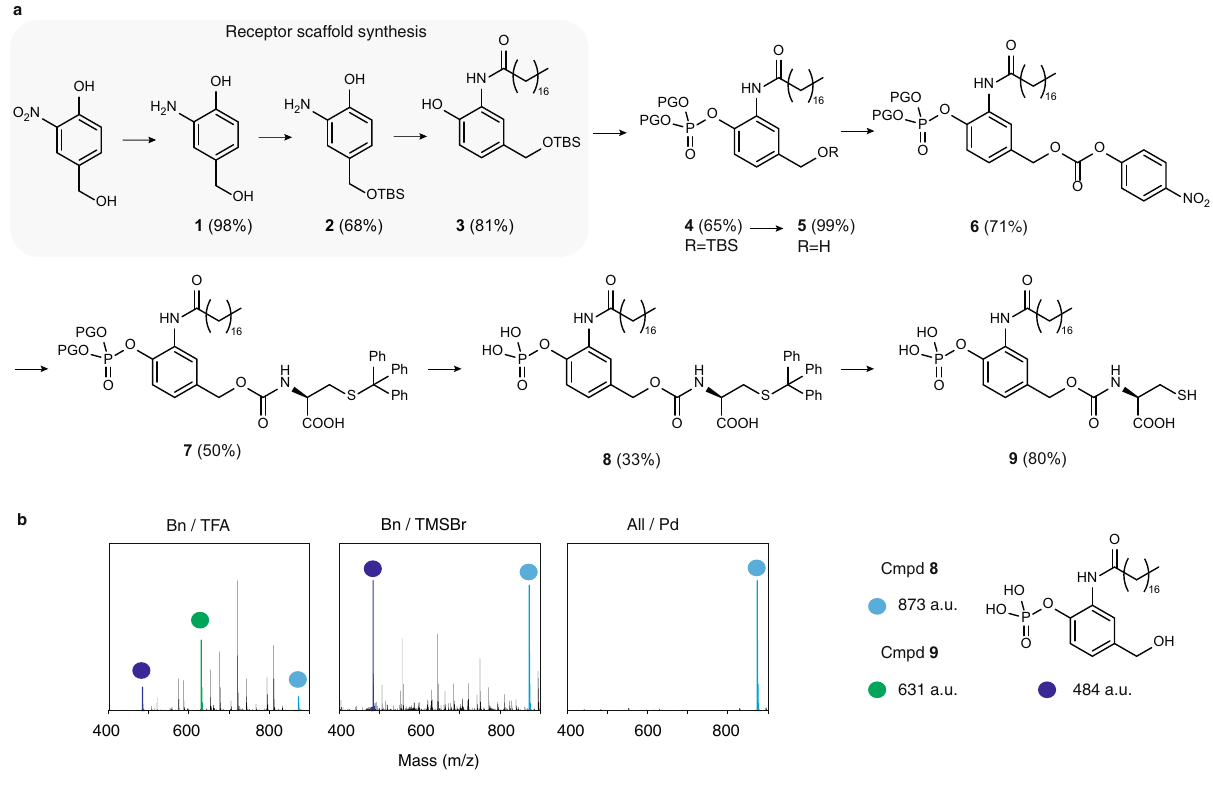
Fig. 2 | Synthetic pathway to phos-EAR molecule. a Schematic illustration of synthesisofthereceptormolecules,startingfrom3-nitro-4-hydroxybenzylalcohol, to the synthesis of a modular receptor scaffold 3 , to the phosphatase-speci fi c enzyme-activating receptor 9 (Phos-EAR). PG=protecting group b HRMS data